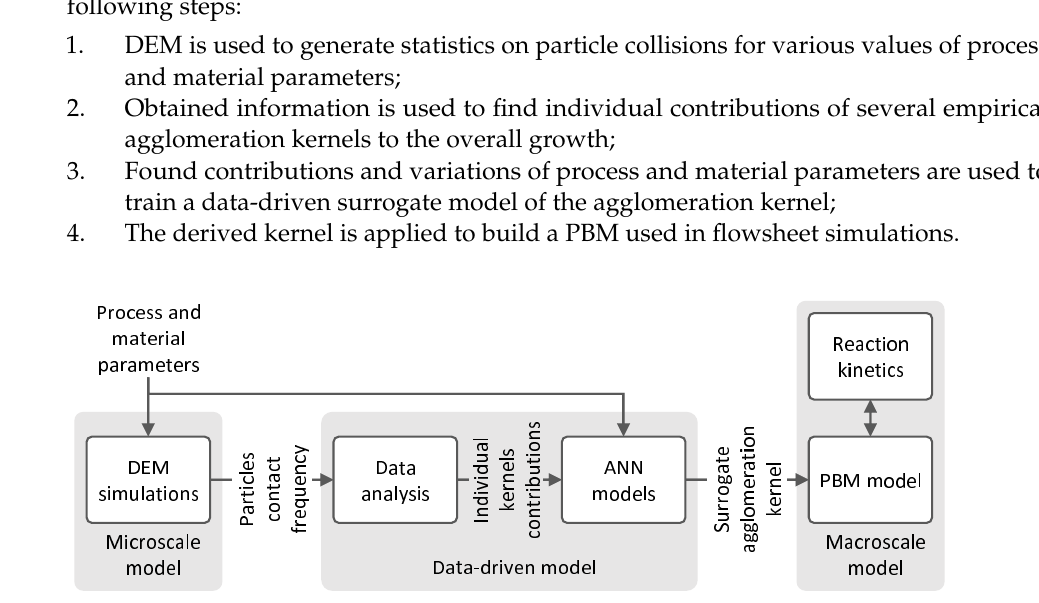
Figure 2. General scheme of the approach to develop a macroscale synthesis model.